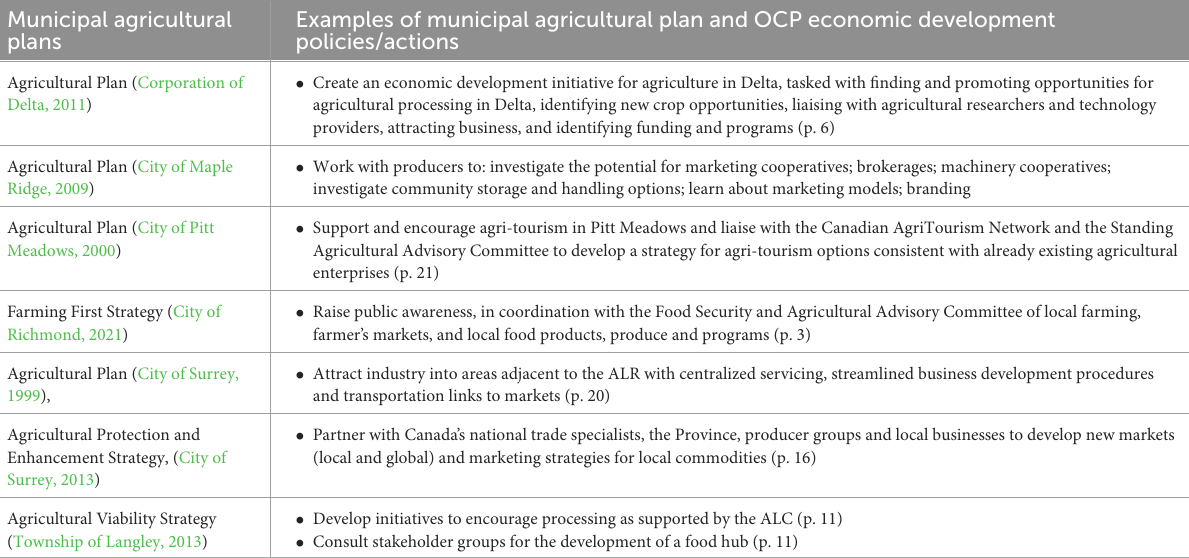
TABLE 1 Examples of different economic development policies/actions identified across municipal agricultural plans in Metro Vancouver, Canada. Municipal agricultural Examples of municipal agricultural plan and OCP economic development plans